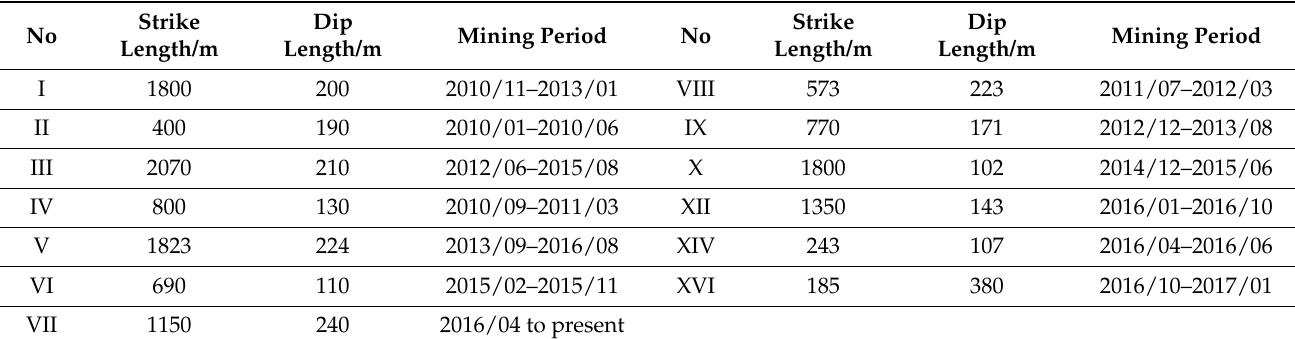
Figure 1. Geographical location and scope of the mining area: ( a ) location of the mining area, ( b ) positions of the working surfaces in the northern mining area, and ( c ) positions of the working surfaces in the southern mining area. Table 1. Mining information for the working